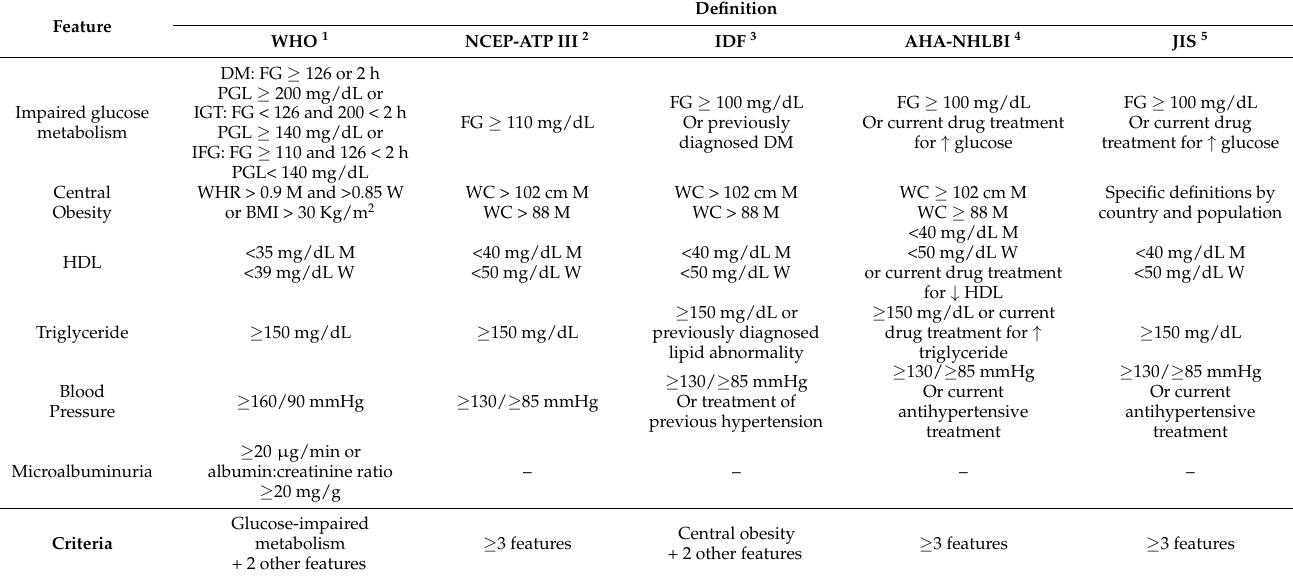
Table 1. Available definitions for metabolic syndrome considering common metabolic